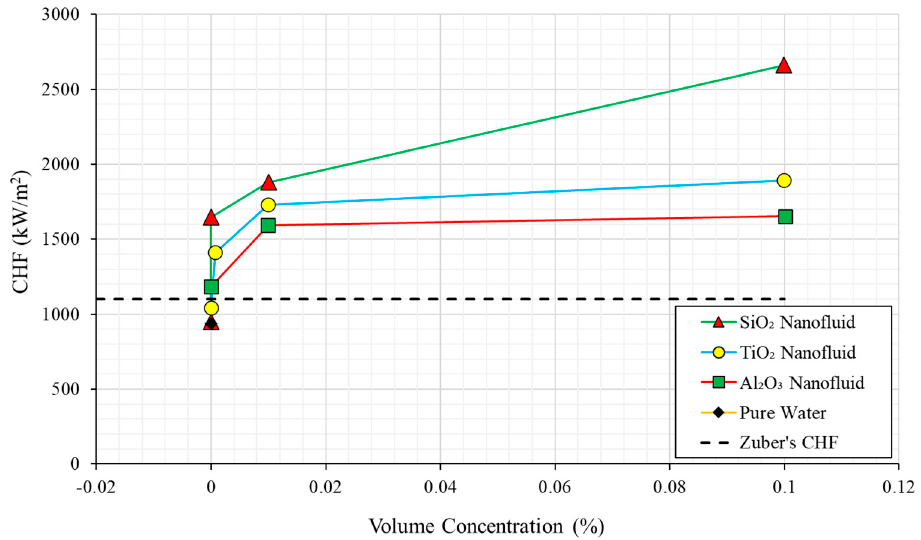
Figure 8. Variations of CHF against volume concentration for pure water and diverse nanofluids. Adapted from Ciloglu and Bolukbasi. Reproduced from [77], Elsevier: 2015.